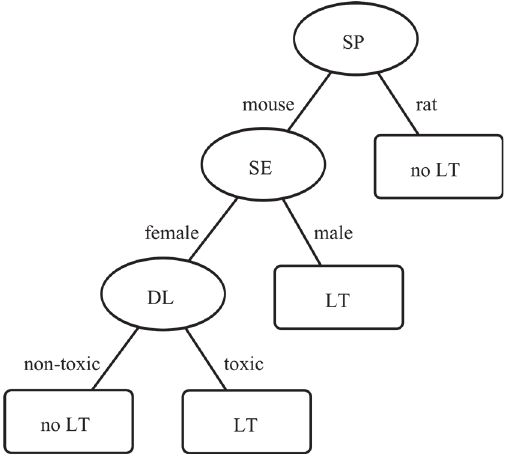
Figure 2. Decision tree to predict liver tumors in case of multi-compounds. The tree was learned using the C4.5 algorithm. It predicts liver tumors (LT) with information about the animal (SP = species, SE = sex), and an indicator for liver toxicity extracted from the dose finding study (DL = dose